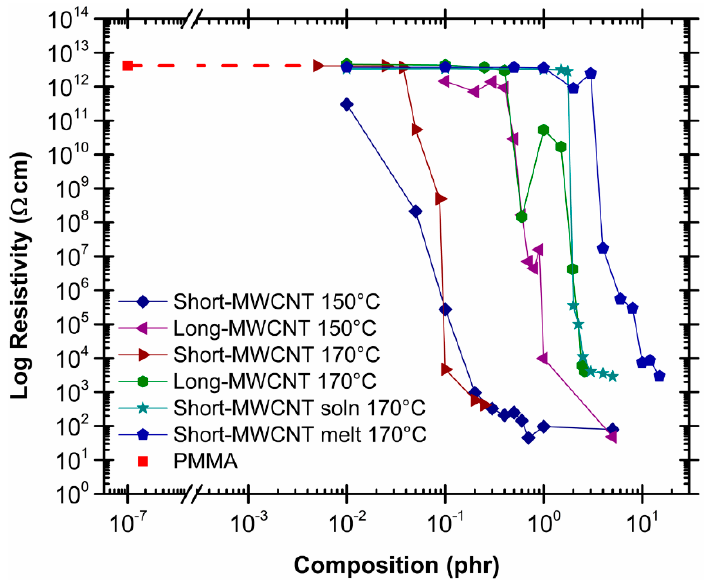
Figure 24. Comparison of two sizes of MWCNTs in PMMA composites with different compression temperatures [9,72].